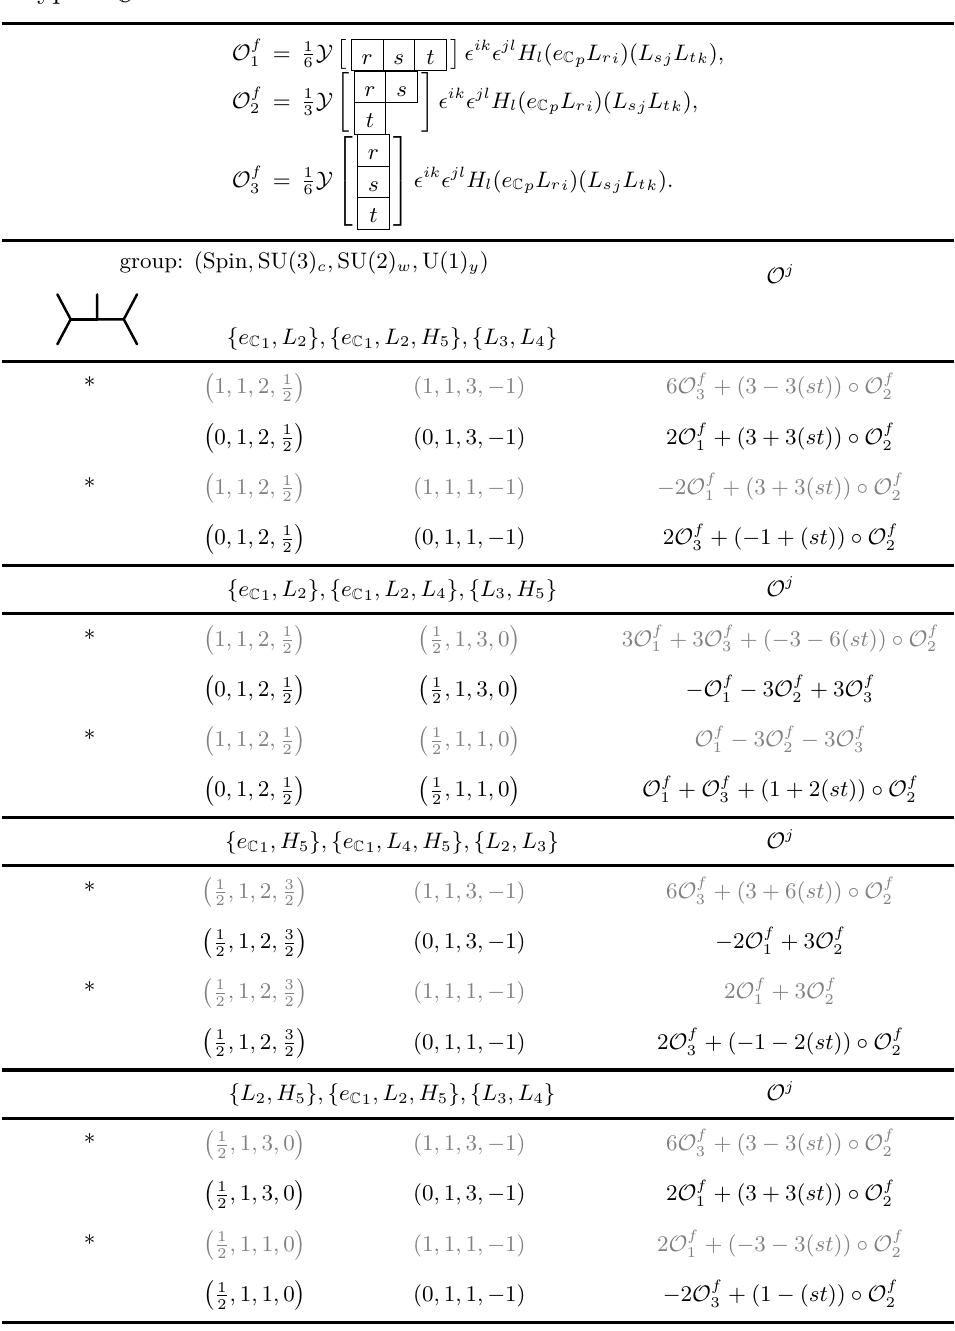
Table 25. UV resonance of topology dim7-4. “*” in front of each row indicates topologies with nonrenormalizable vertices. The UV resonances colored in gray are eliminated by UV